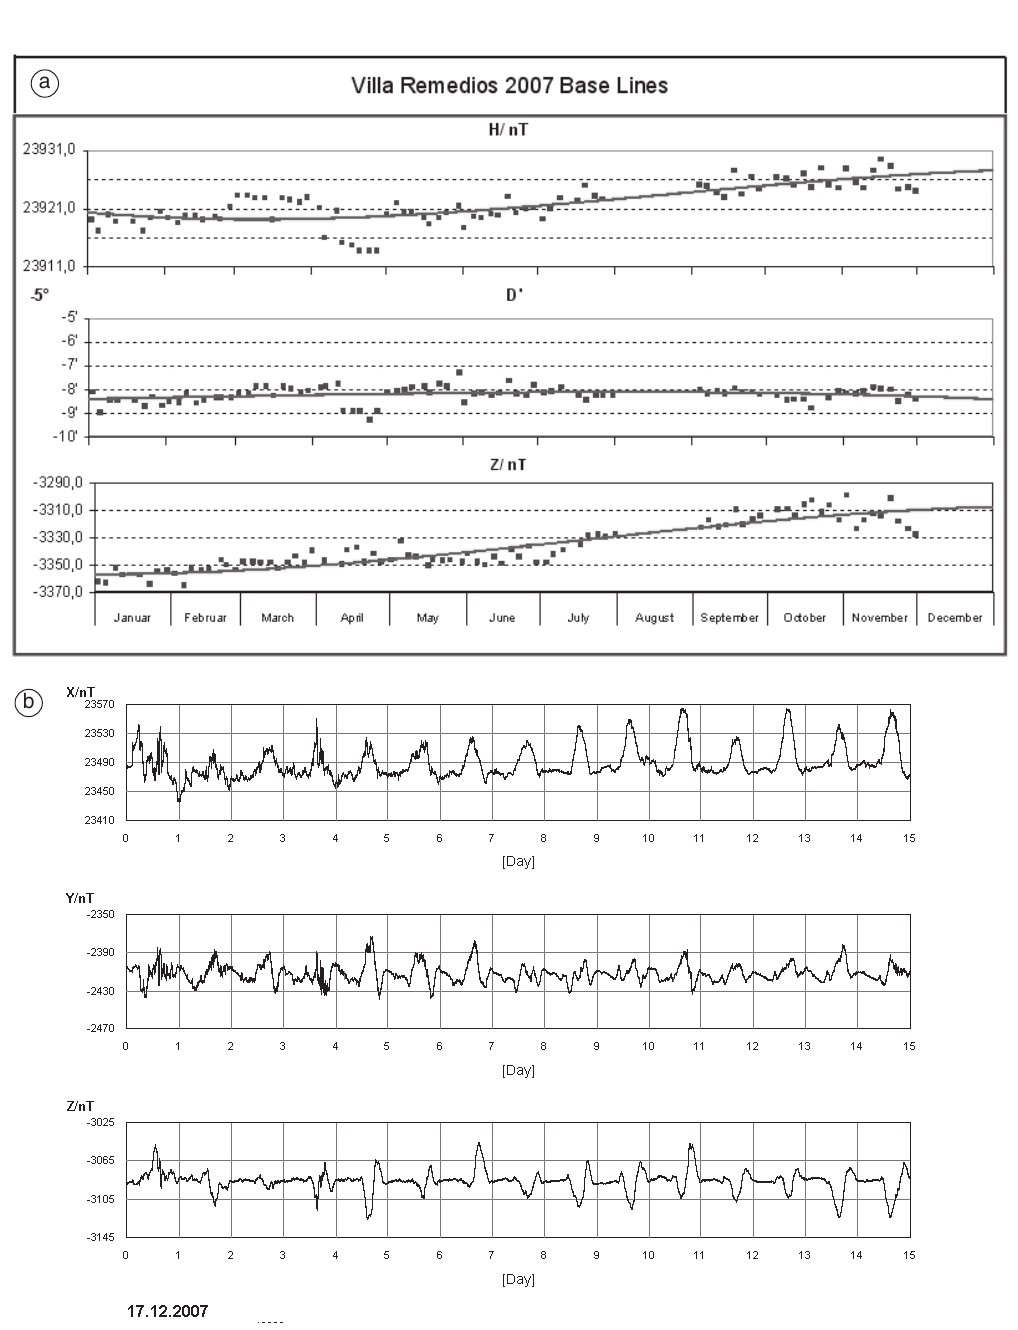
Fig. 4a,b. Expamples for data from VRE observatory. a) Measured (black dots) and adopted (grey line) base- lines for 2007. The moderate variation is due to seasonal temperature changes in the variometer hut. b) One minute values of the north (X), east (Y) and vertical (Z) component for the time interval December 17 to 31,